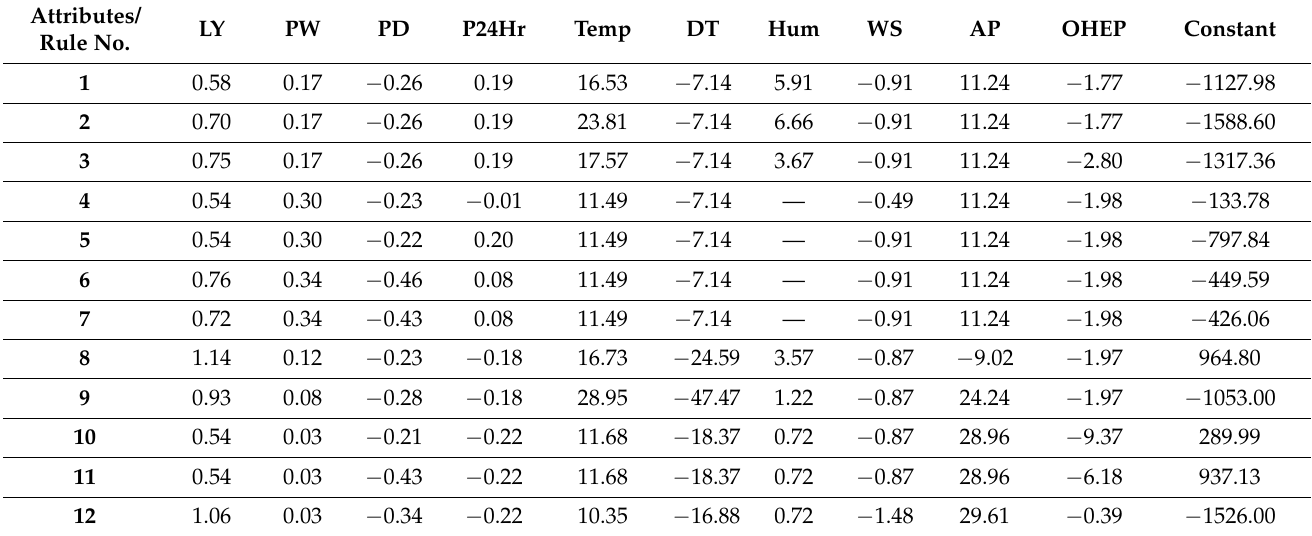
Table 5. The Coefficients of Each Predictor In Each Rule.